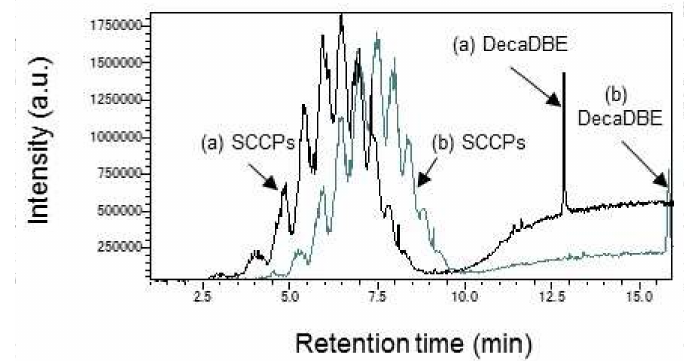
Figure 4. TIC Chromatogram using Py/TD–GC–MS at SCCPs and DecaBDE. Black line (a): the initial and final column temperatures are 80 to 300 ◦ C at 20 ◦ C/min. Gray line (b): 60 to 280 ◦ C at 20 ◦ C/min. GC was run by the preconditioned sample conditions except for the column temperature.